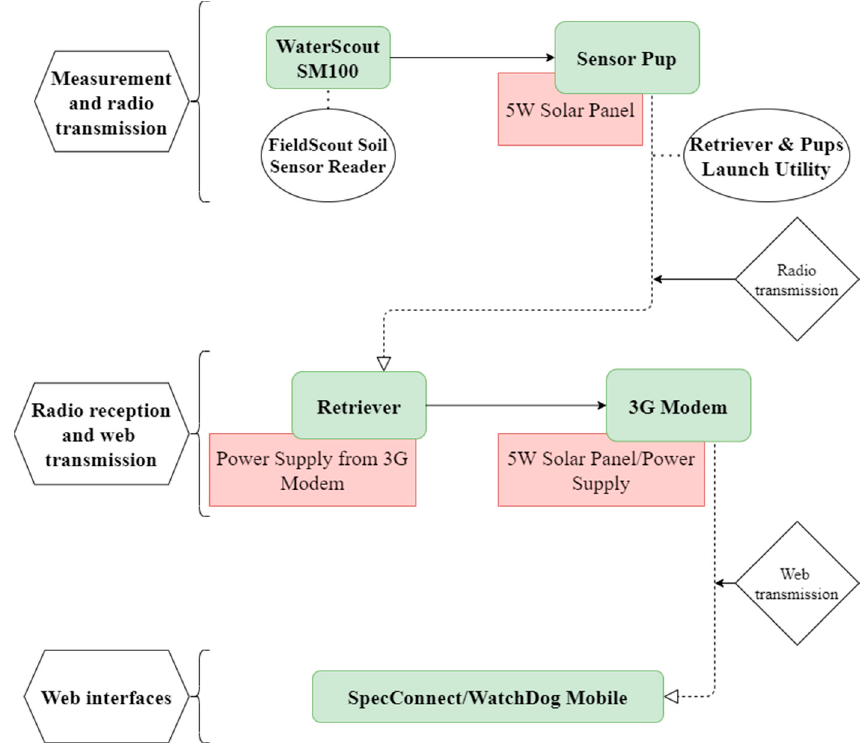
Figure 3. Flow chart of the monitoring network (Retriever & Pups Launch Utility: Version 1.2.7.3, Copyright 2016 Spectrum Technologies Inc., Aurora, IL, USA 60504).